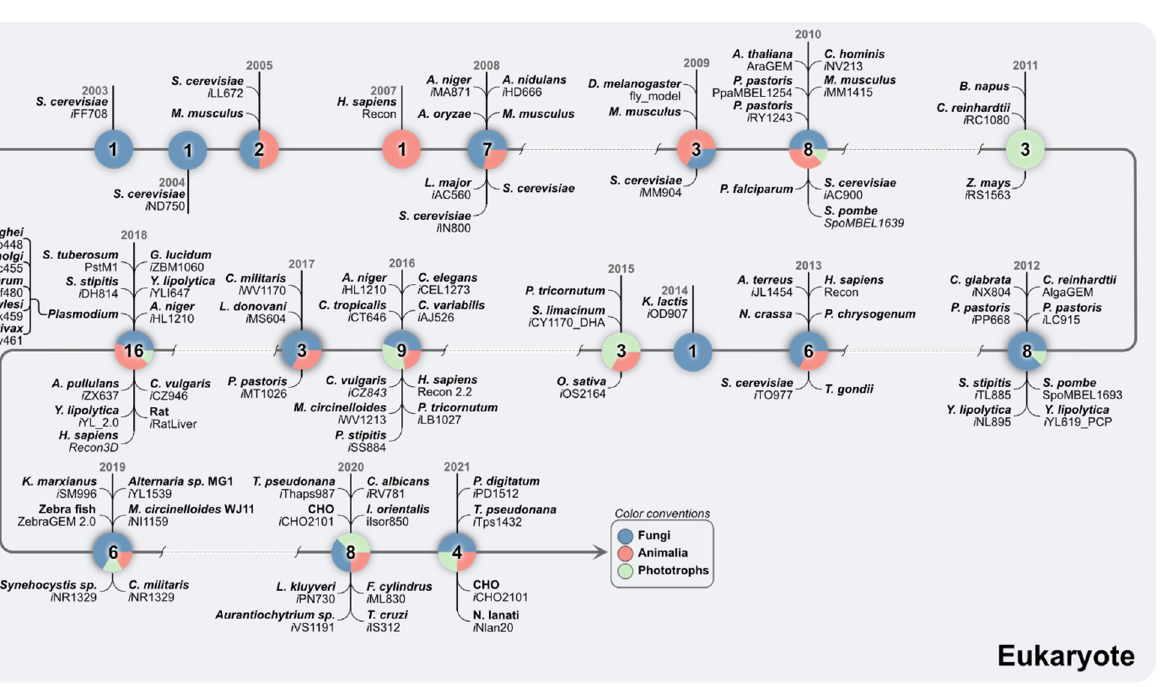
Figure 5. Chronological order of GEMs of important model eukaryotic organisms. Each node depicts the year of GEM reconstruction and the number of GEMs reconstructed for that organism. The nodes are color coded to depict the classification of GEMs into Fungi (blue), Animalia (pink) and Phototrophs (green) (Supplementary File S4).